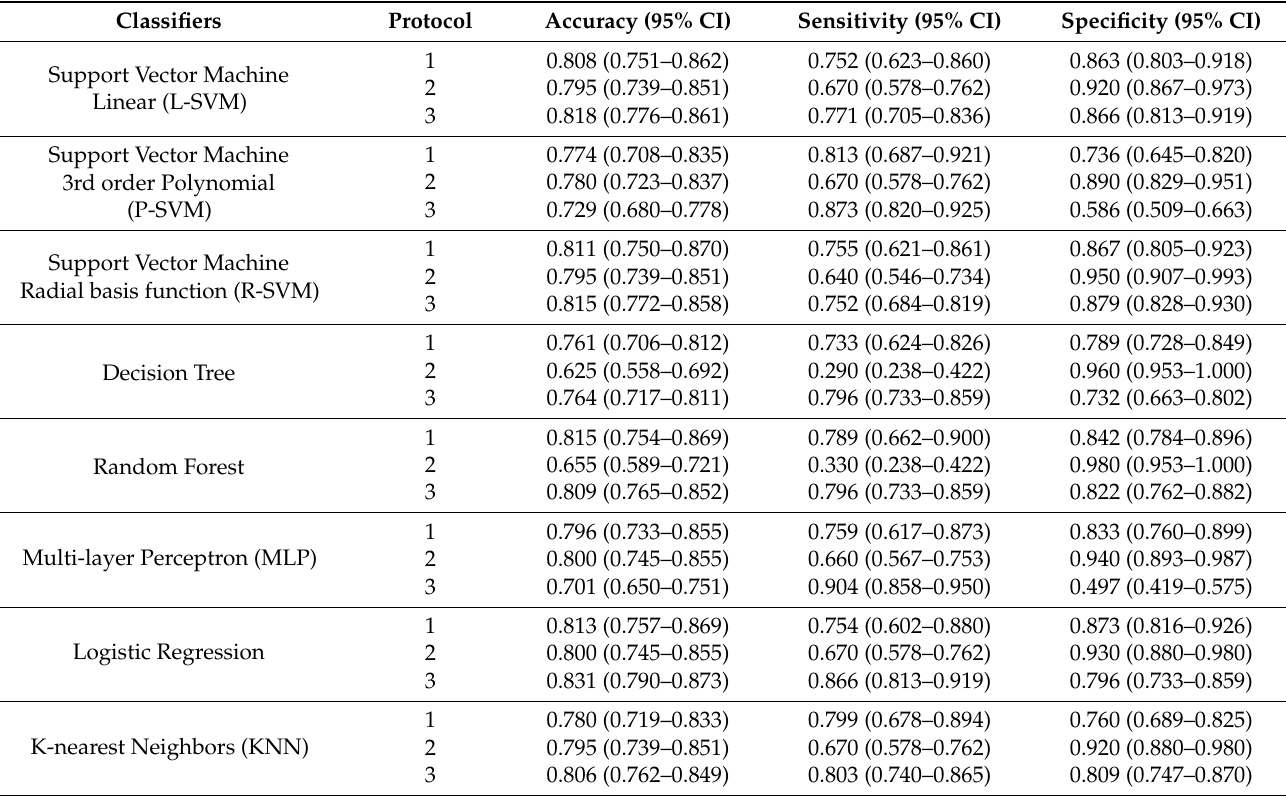
Table 3. Machine-learning results for both EP and TG datasets.